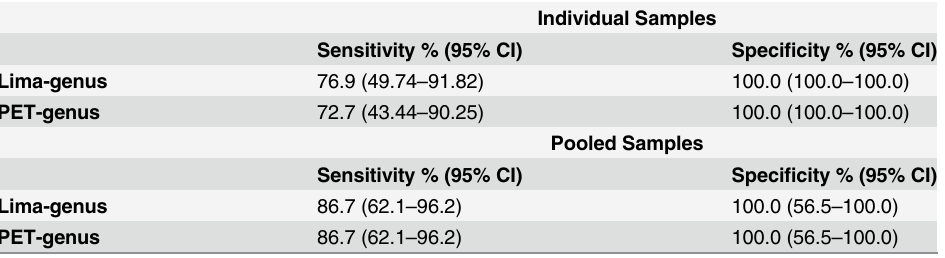
Table 4. Sensitivity and specificity of the genus molecular assays in individual and pooled